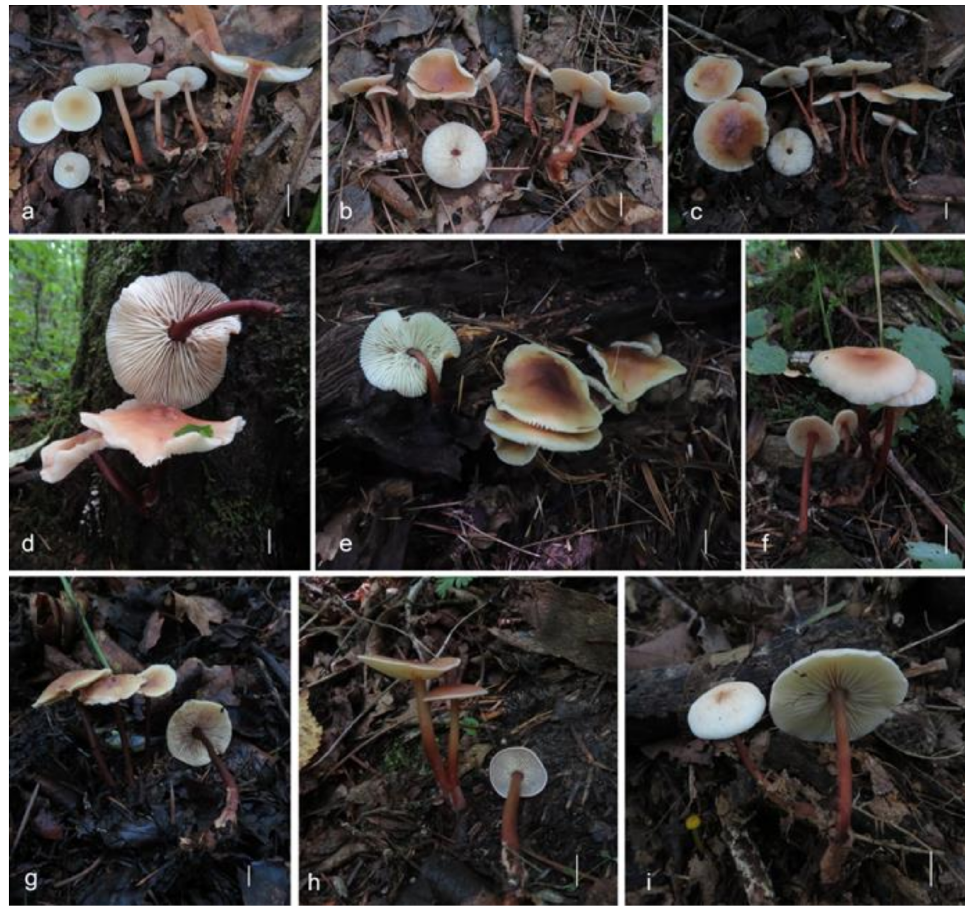
Figure 3. Fresh basidiomata of Gymnopus species: ( a ) Gymnopus longisterigmaticus (Holotype, HMJAU 60288), ( b ) Gymnopus longus (Holotype, HMJAU 60291), ( c ) Gymnopus macrosporus (Holotype, HMJAU 60294), ( d ) Gymnopus tiliicola (Holotype, HMJAU 60304), ( e ) Gymnopus globulosus (Holotype, HMJAU 60308), ( f ) Gymnopus changbaiensis (HMJAU 60300), ( g ) Gymnopus striatus (Holotype, HMJAU